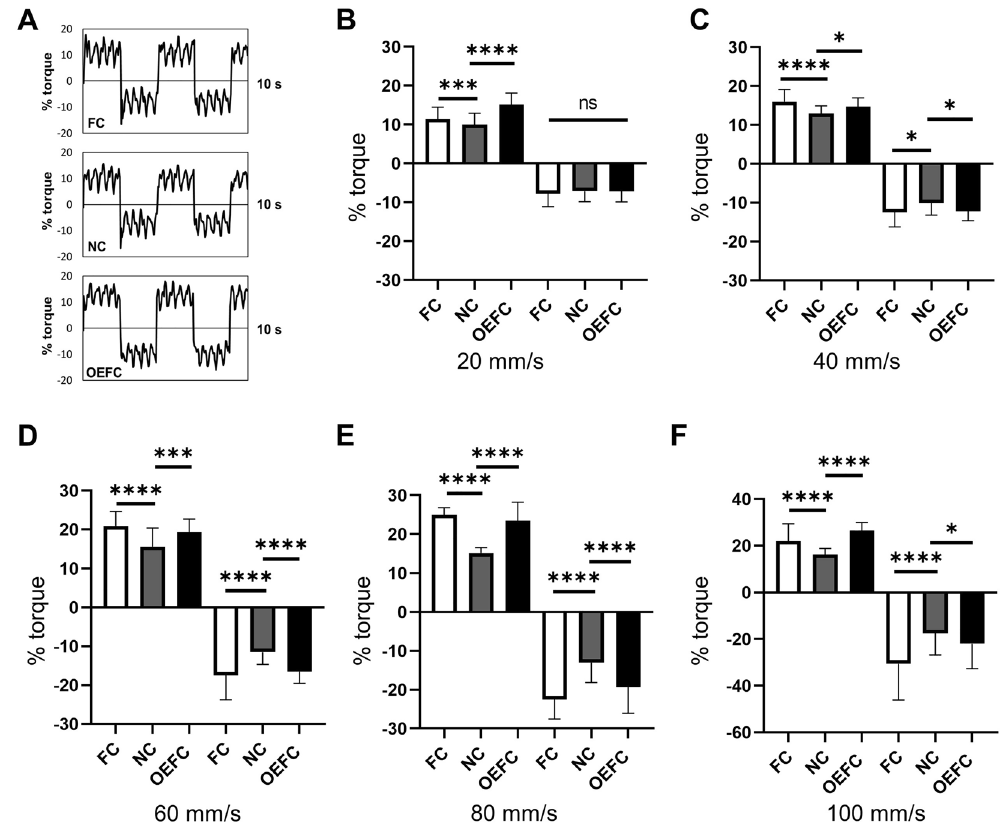
Figure 3. Force required for irrigation. ( A ) Images of the output waveform of the required force (% torque) when the operation was performed at 20 mm/s in water. The force required in the pulling direction was indicated as plus and the force required in the pushing direction was indicated as minus. ( B – F ) Multiple comparisons of average values of the force required for pulling and pushing at a velocity of 20, 40, 60, 80, and 100